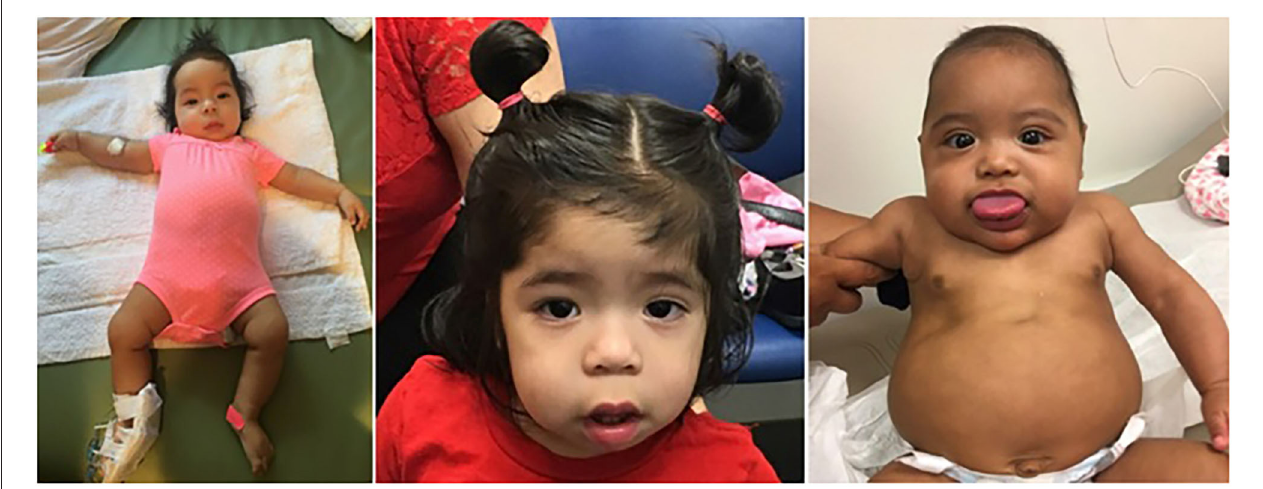
FIGURE 1 | Two infants diagnosed with Beckwith–Wiedemann syndrome. The first infant (left and middle), presented with two episodes of symptomatic hypoglycemia, first occurring shortly after birth, and the second one at 7 months of age. Note the right-sided hemihyperplasia involving the right upper and lower extremities (1–1.5cm difference in humeral and tibial circumferences, a 6% difference). Facial asymmetry was appreciated at 7 months, but can be readily seen in the middle, taken at 19 months of age. Extremity or facial asymmetry should raise suspicion for this syndrome. The patient in the right demonstrates the syndrome’s most prominent feature, macroglossia. Methylation studies showed that the IC1 was hypermethylated: the paternal IC1 center is typically methylated, and maternal allele is not. Both patients undergo Beckwith–Wiedemann spectrum (BWSp)-specific cancer surveillance as depicted in Table 2